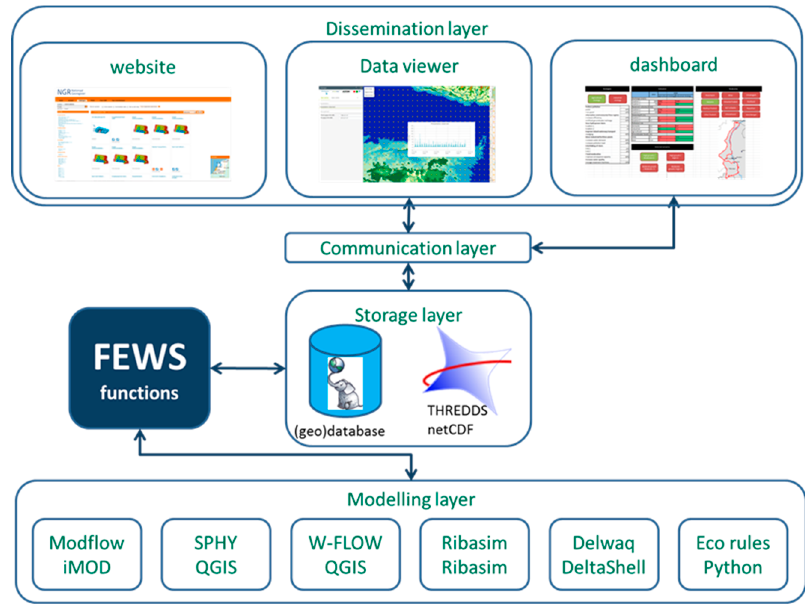
Figure 6. GangaWIS ( water information system ) structure.